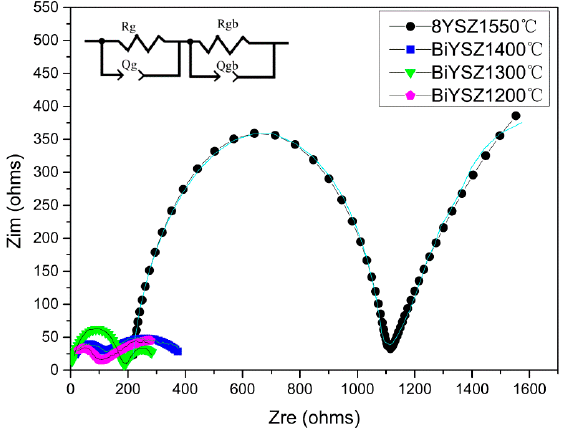
Figure 8. Nyquist plot of 8YSZ sintered at 1550°C and 2Bi-10YSZ sintered at various temperatures.